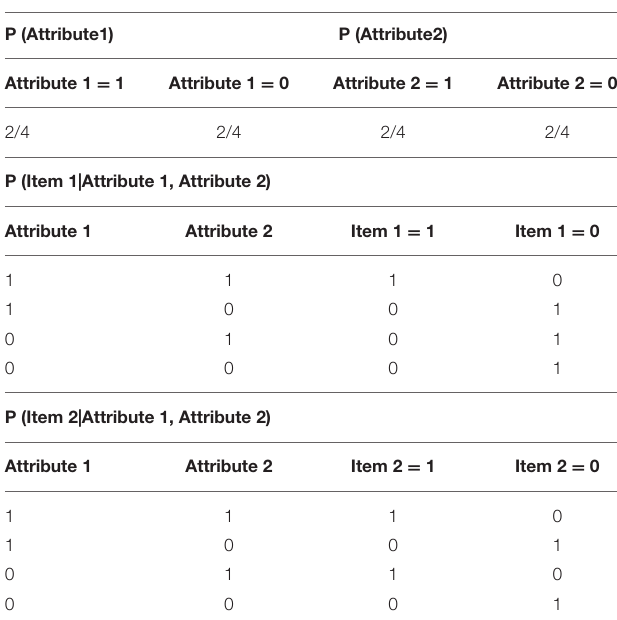
TABLE 3 | The conditional probability table of the Bayesian